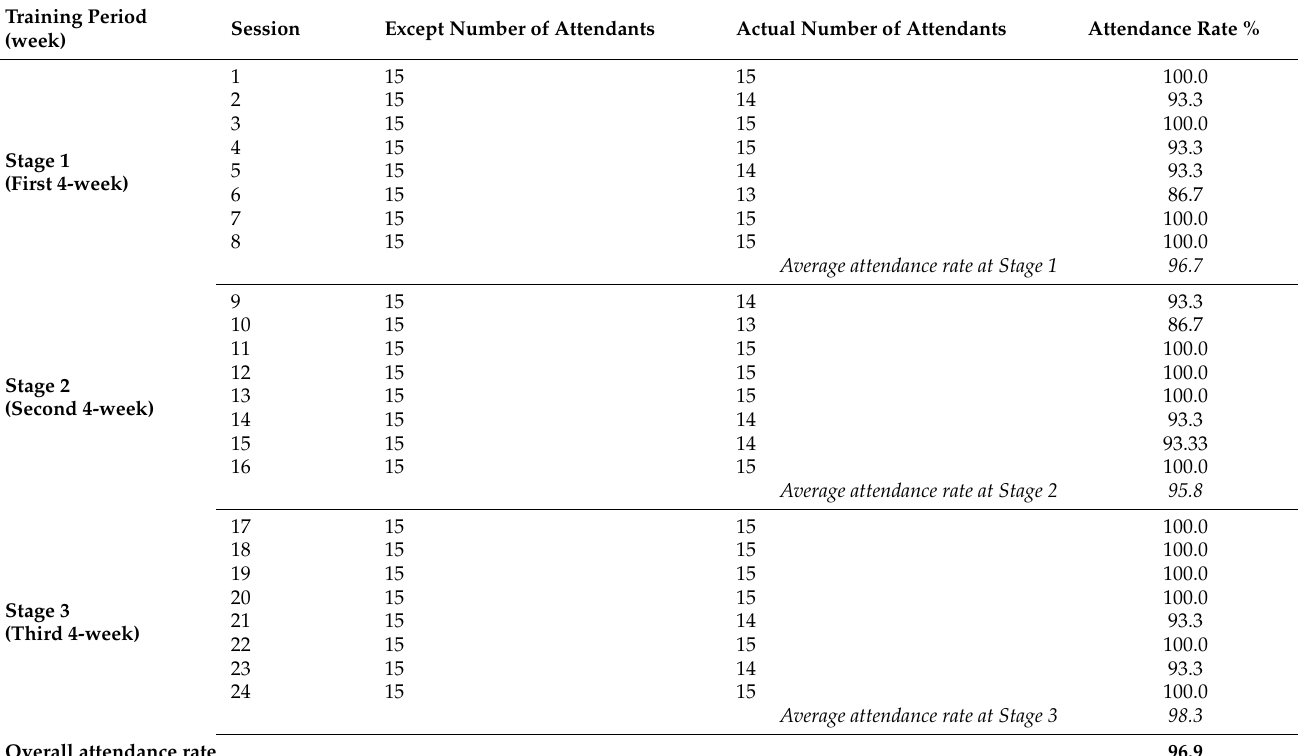
Table A3. Attendance rate of the 12-week physical activity program.